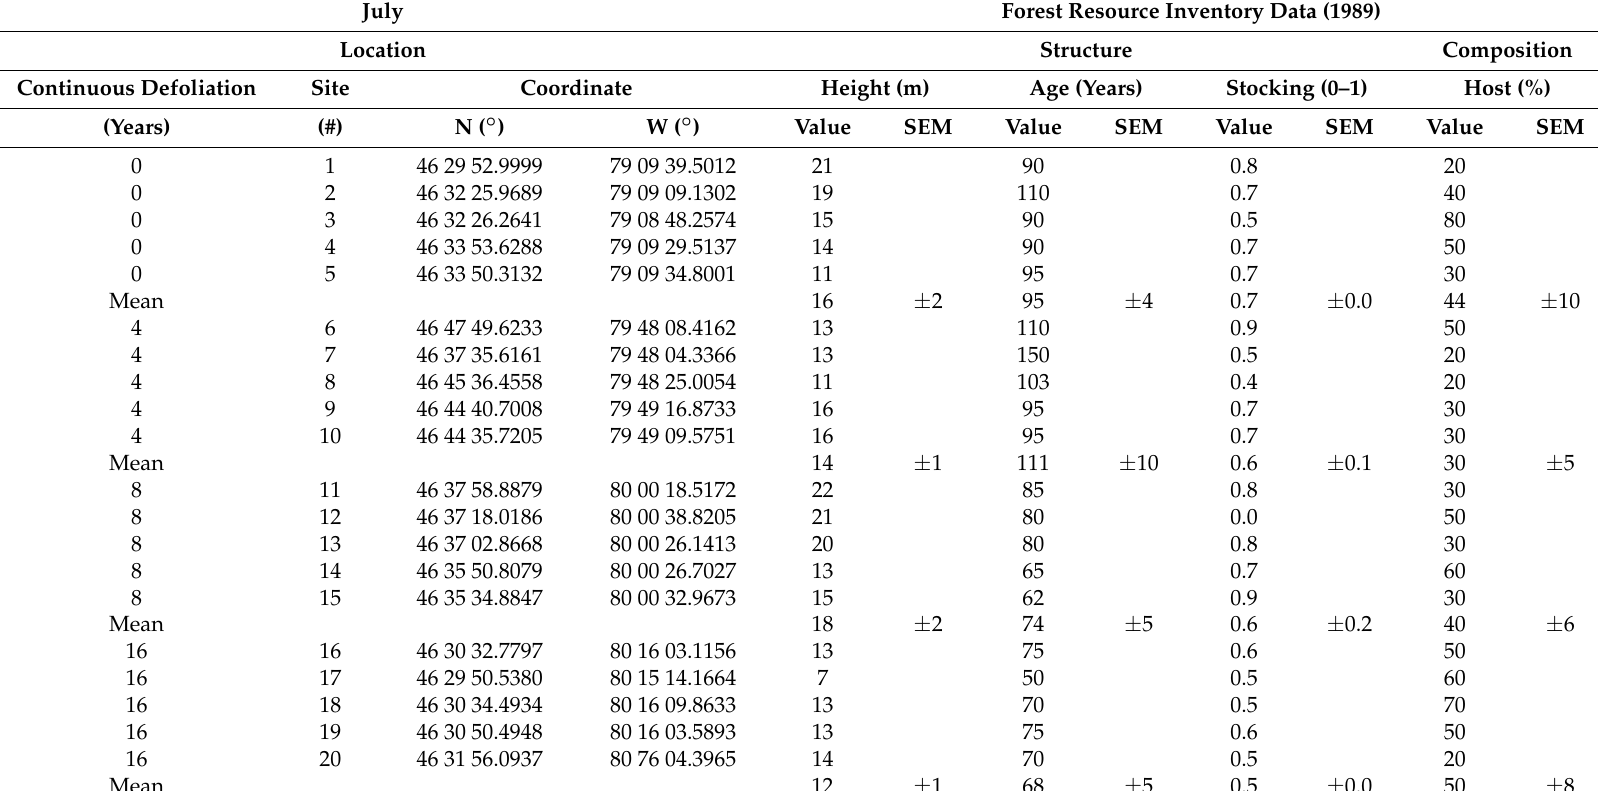
Table 1. Geographic locations and Forest Resource Inventory (FRI) data pertaining to the 20 sites inventoried in July 2011. Sites were located within boreal mixedwood forest continuously defoliated by spruce budworm for 0, 4, 8, and 16 years from 1993–2008. FRI data for these sites were collected in 1989 by the Ontario Ministry of Natural Resources (OMNR), three years prior to the start of the defoliation period. Stocking is a relative measure of stand density against the reference level for the dominant and co-dominant species. Height and Age pertain to the dominant and co-dominant trees of the leading species in the stand, averaged over the stand. The reported value of a given metric is represented by Value, while standard error of the mean is represented by SEM. Host trees include balsam fir, white spruce, and black